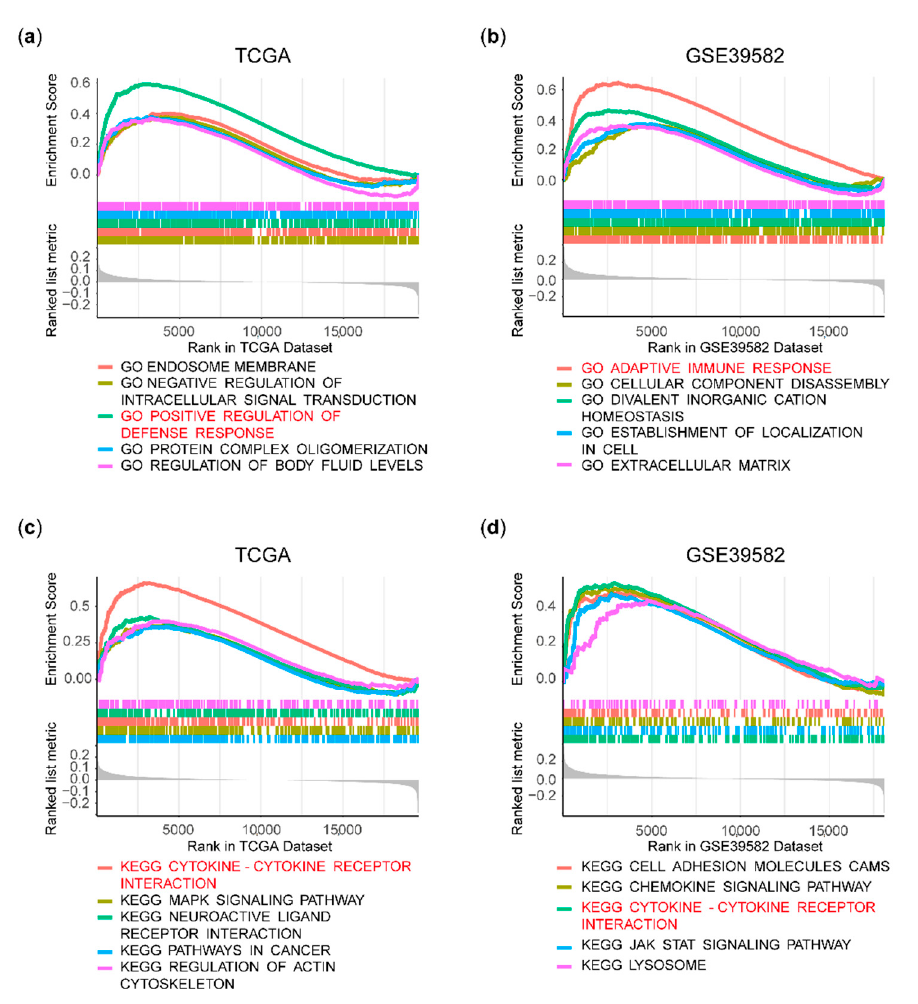
Figure 5. Gene set enrichment analysis based on GO terms ( a , b ) and KEGG terms ( c , d ) in TCGA and GSE39582. The top enriched terms were colored in red. GO, Gene Ontology; KEGG, Kyoto Encyclopedia of Genes and Genomes.